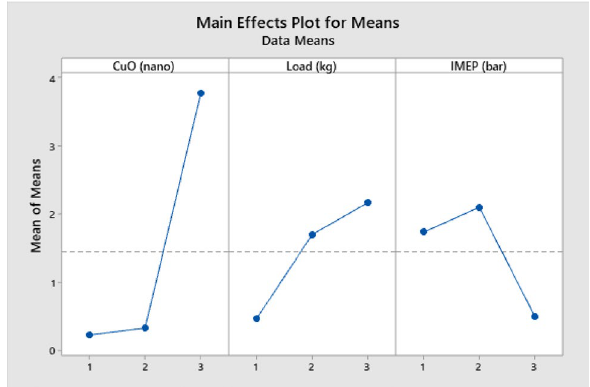
Fig. 9 Investigation by Taguchi: CO IMEP (bar)